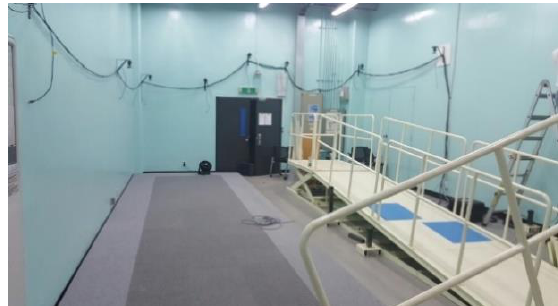
Figure 1. Panorama of the motion analysis lab.